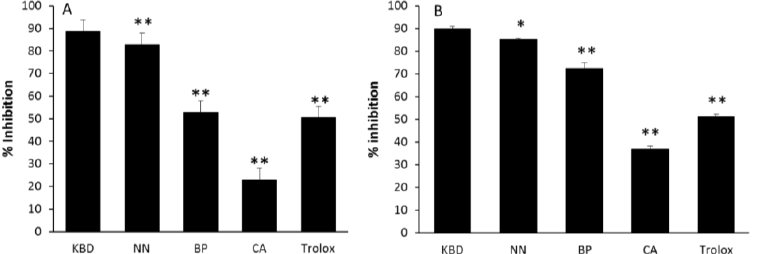
Figure 1. The effect of ethanol extracts of the KBD and its components on ABTS (A) and DPPH (B) radical scavenging action. The KBD extract of 3 mg/mL (KBD) and its components at equivalent amounts, i.e., Nelumbo nucifera 1 mg/mL, (NN); Piper nigrum 1 mg/mL (BP), and Centella asiatica 1 mg/mL (CA), were evaluated for radical scavenging action by ABTS and DPPH assay. The values are reported as means ± SD ( n = 5). * p < 0.05 and ** p < 0.01 as compared with the KBD group. Trolox at the concentration of 80 and 20 µ M was used as a positive control in ABTS and DPPH assay, respectively.